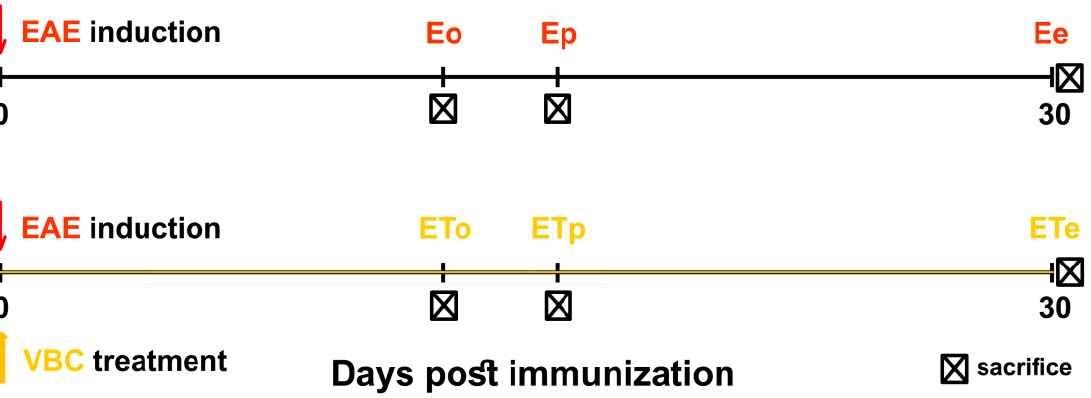
Figure 1. Illustration of the experimental design and time points of animal sacrifice . Untreated EAE rats ( E ), VBC-treated EAE rats ( ET ), onset ( o ), peak ( p ), and end ( e ) time points.